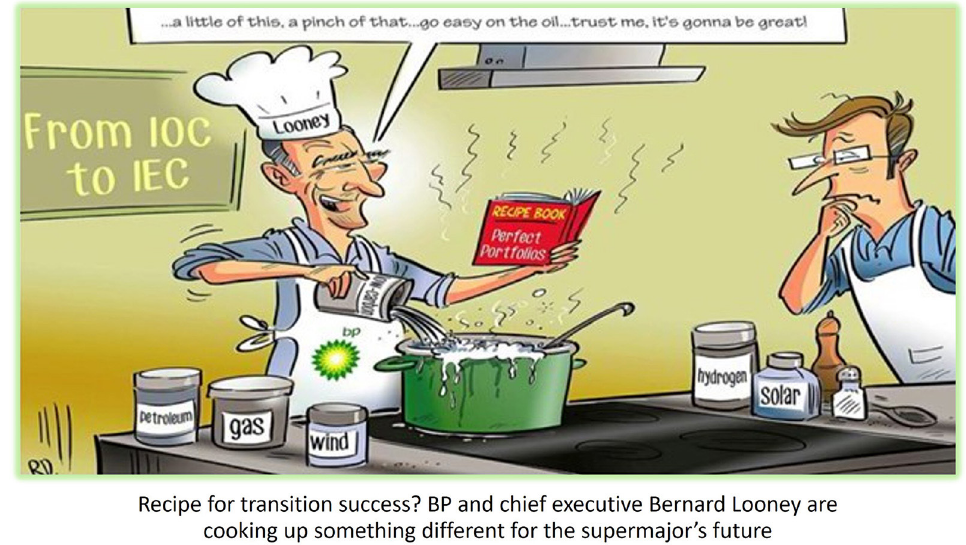
Fig. 26. – Transitioning from an International Oil Company (IOC) to an International Energy Company (Source: Rytis